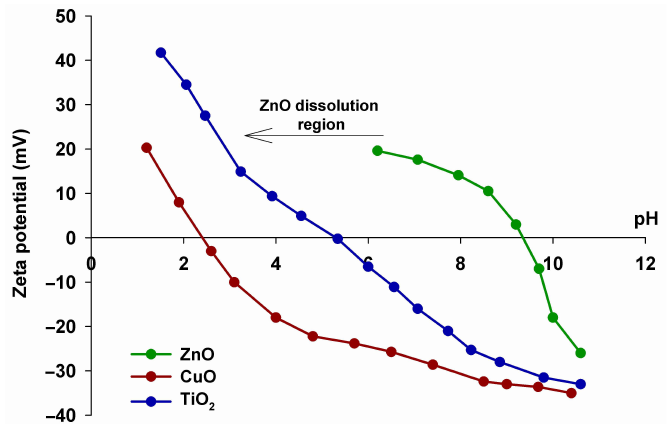
Figure 4. Zeta potential versus pH of pristine